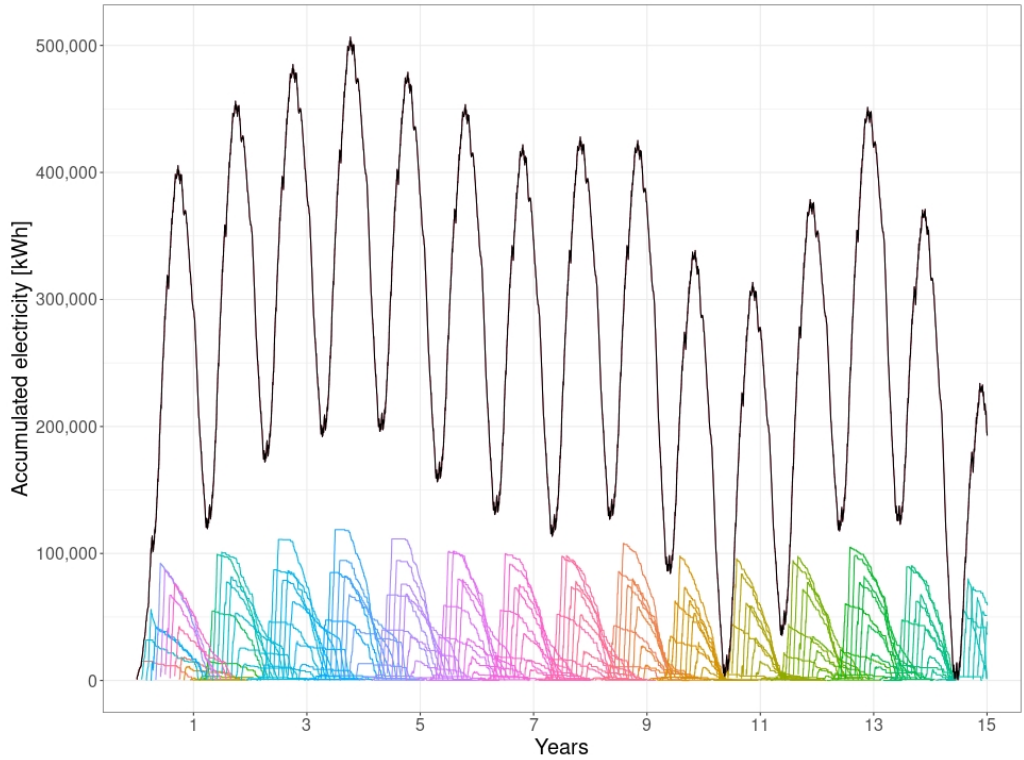
Figure 7. Energy flow in the network deposit for an example energy cooperative using PV for a 15-year period of analysis.